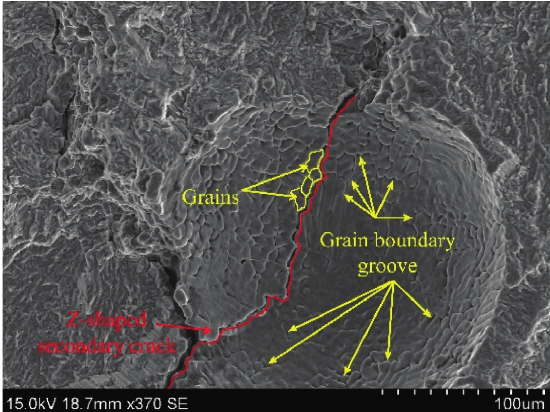
Figure 13: Partial enlargement of Figure 8(b).